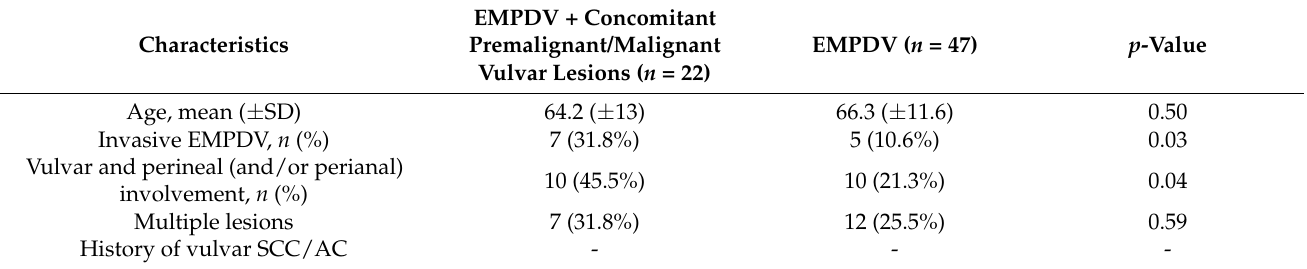
Table 2. Comparison between women with EMPDV and concomitant vulvar premalig- nant/malignant lesions and women diagnosed only with EMPDV during the study period.